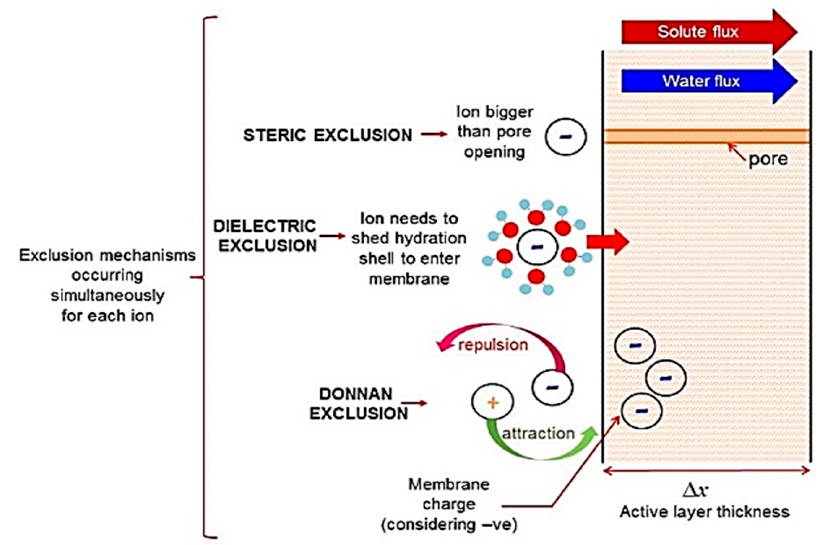
Figure 7. Schematic representation of solute exclusion mechanisms in nanofiltration [75].